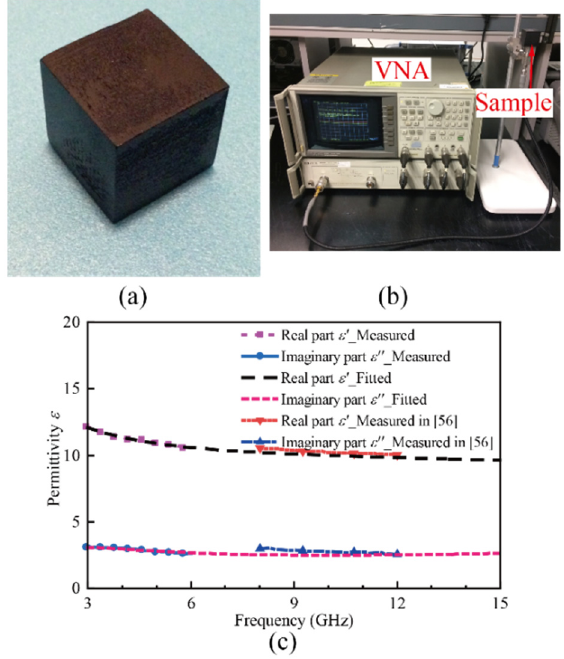
Figure 2. ( a ) Image of the printed cube sample; ( b ) The experimental setup of the permittivity measurement system; ( c ) Measured and fitted data of the permittivity of the material.